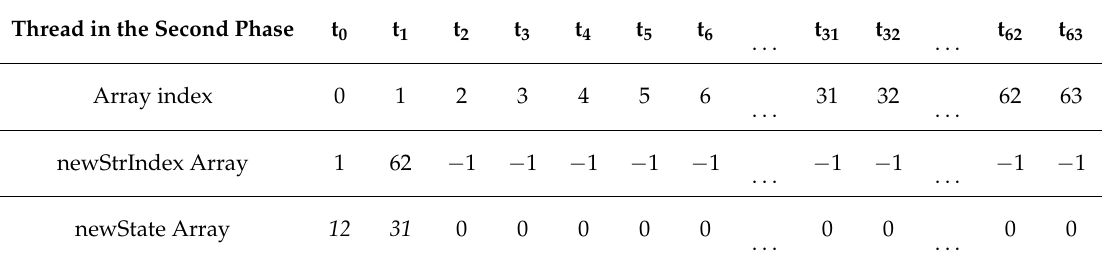
Table 5. The information about the job mapping in the second phase.